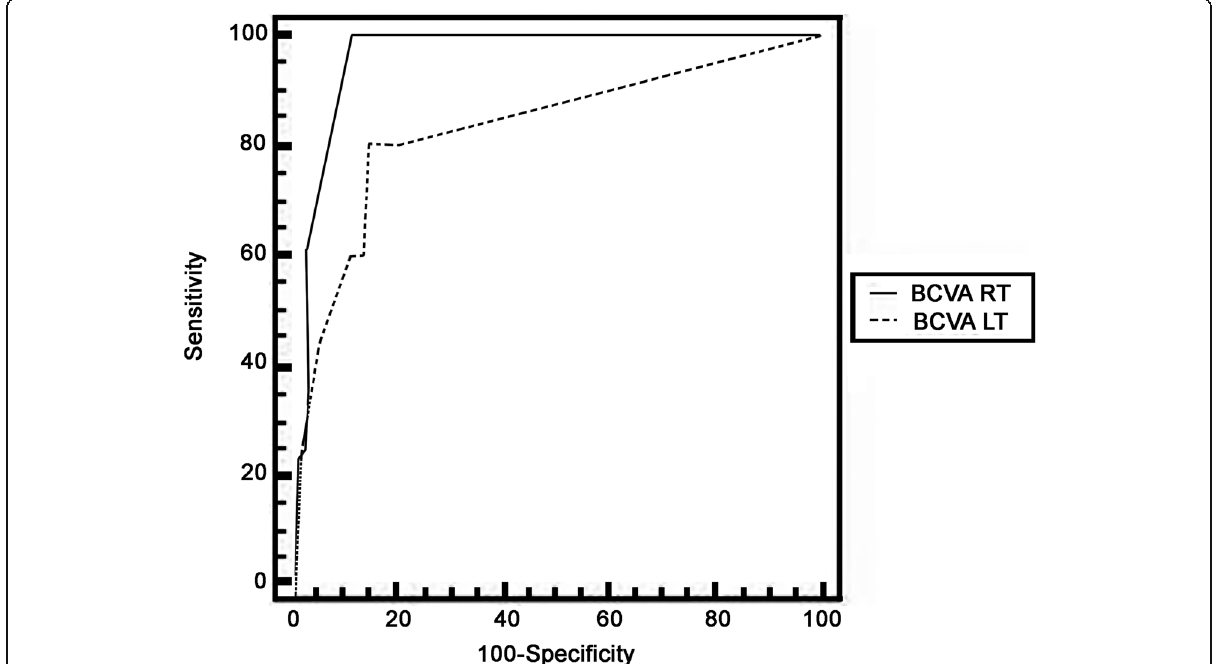
Fig. 5 Receiver operating characteristic curve (ROC) for (BCVA) as a predictor of abnormal FAF